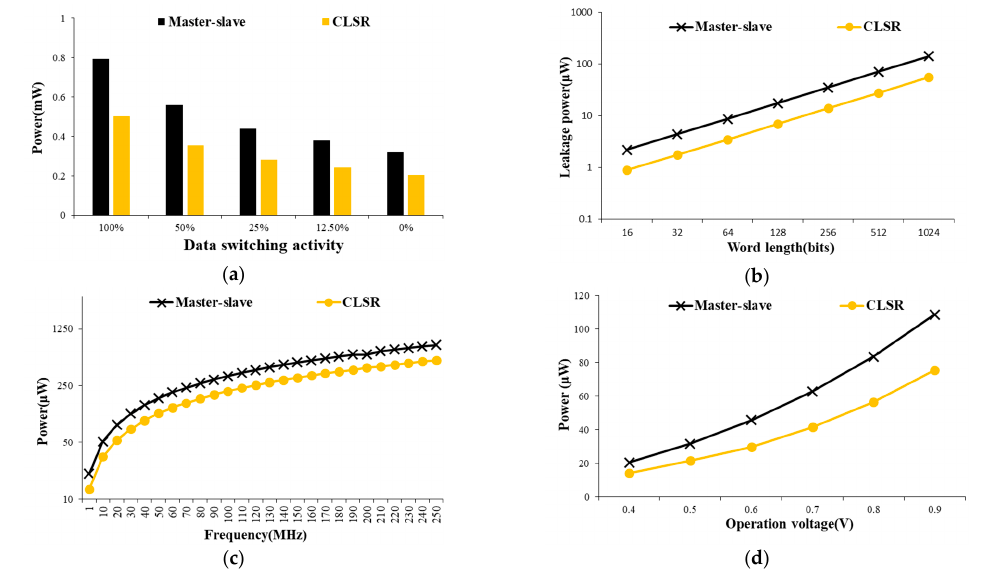
Figure 9. Power consumption performance. ( a ) Different data switching activity. ( b ) Leakage power. ( c ) Different operation frequency. ( d ) Different supply voltage.